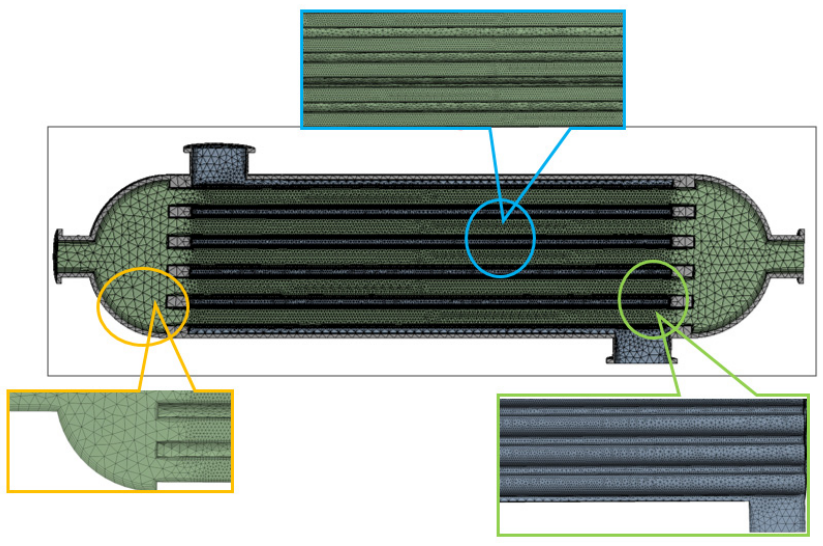
Figure 2. Section and partial drawing of finite element meshing of heat exchanger.